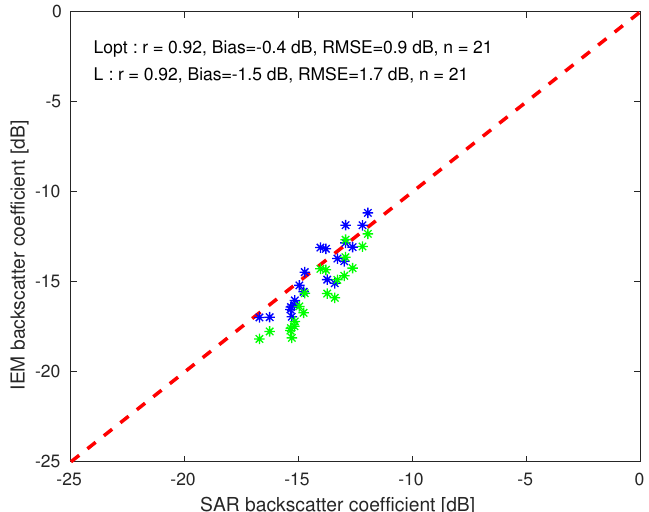
Figure 6. Comparison between backscattering coefficients derived from Sentinel-1 images and those simulated by the IEM model at VV polarization using measured L (green color) and optimal Lopt (blue color) correlation length for the validation data ( n =